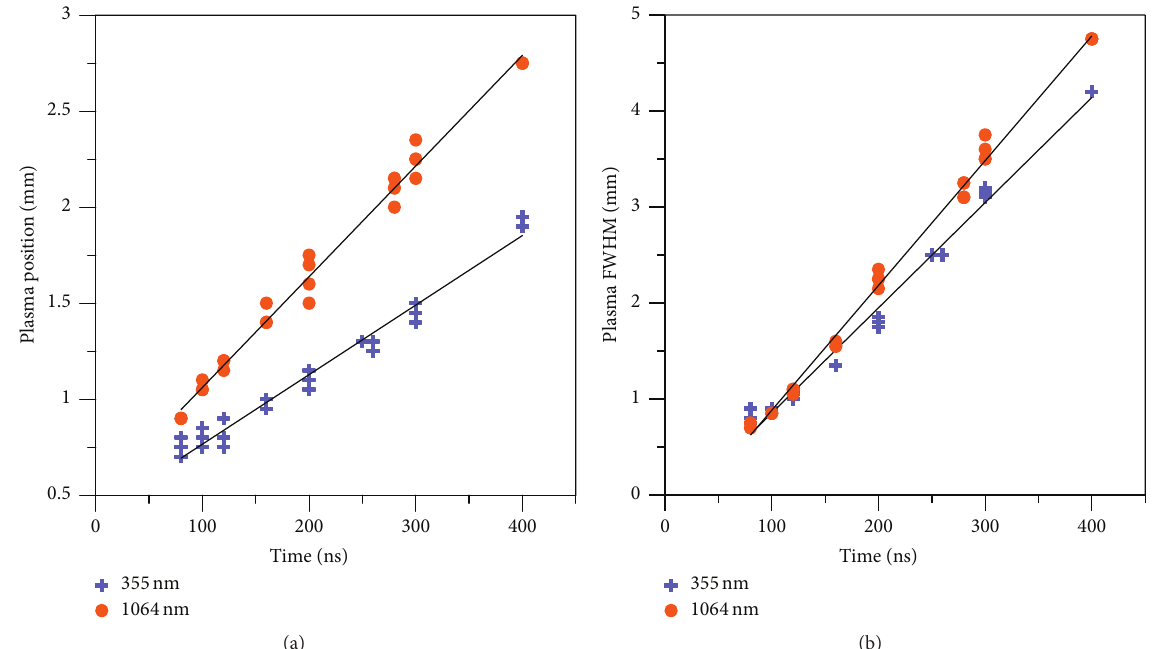
Figure 13: Experimental tungsten plasma plume parameters for 1064 and 355 nm laser wavelengths. (a) Velocity of plasma propagation and (b) velocity of plasma